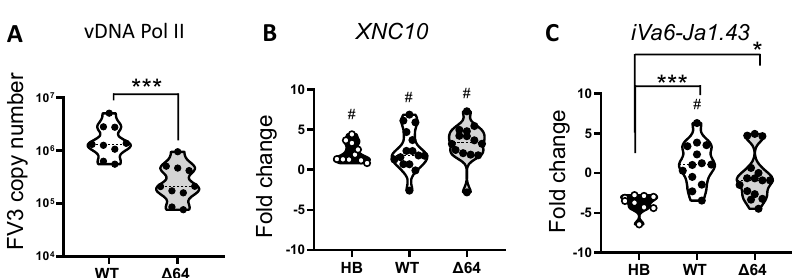
Figure 1. E ff ects of infection with attenuated knockout (KO) FV3 recombinant or bacterial stimulation on iV α 6 T cell response. Peritoneal leukocytes (PLs) were collected at 1 dpi from adult frogs infected with 1 × 10 6 PFUs of WT-FV3 or ∆ 64-FV3, or 100 µ l heat-killed (HB) E. coli . ( A ) Genome